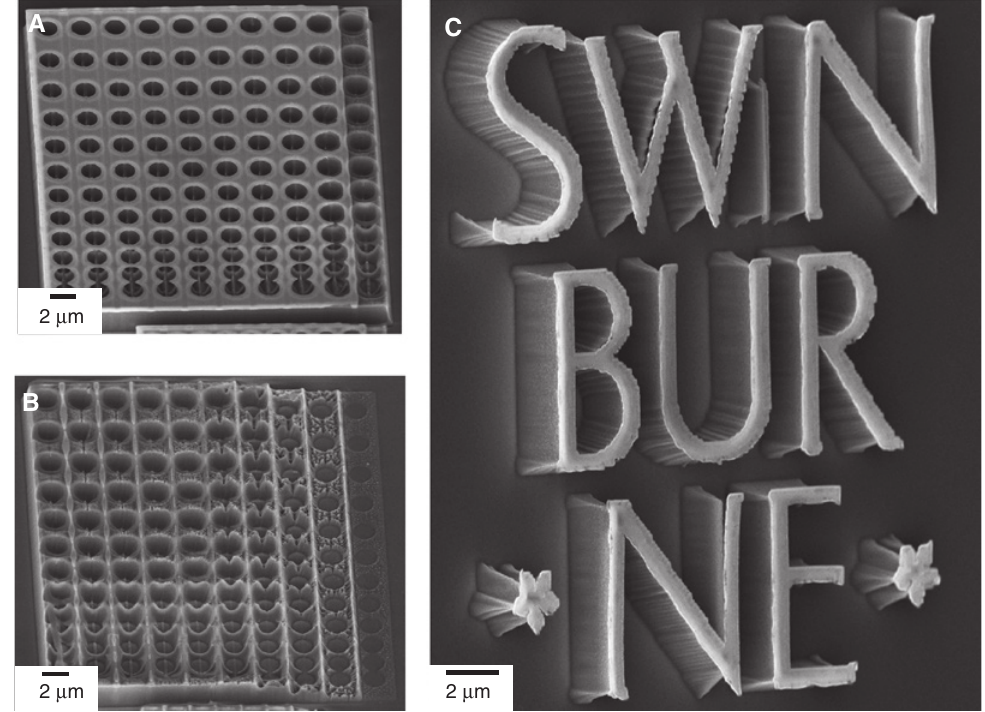
Figure 9: Representative SEM image of an array of FIB irradiated areas at Ga + ion doses left to rigtht (A) 200−20 μ C/cm 2 and (B) 20−1 μ C/cm 2 , after RIE-ICP etch. (C) shows Swin logo made with optimal Ga + dose (100 μ C/cm 2 ). ICP-RIE etching was performed in a 1 Pa pressure of SF